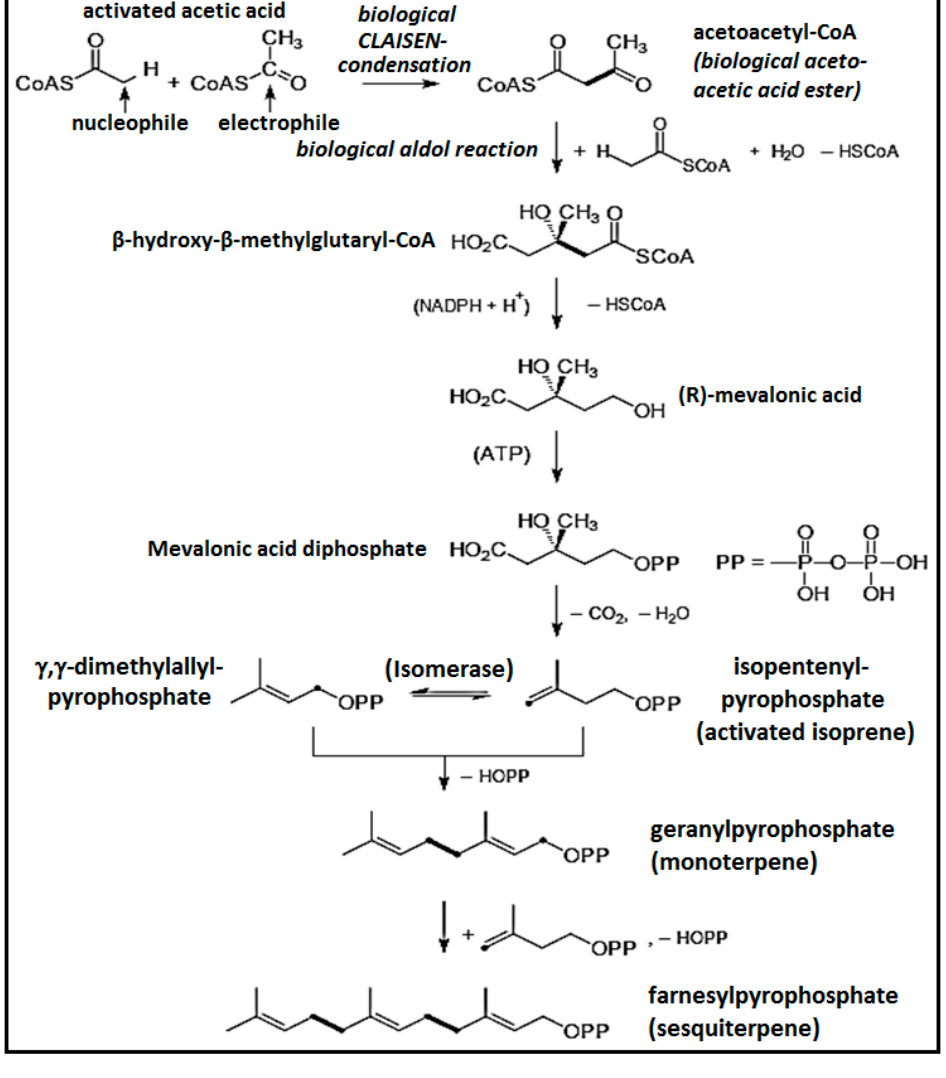
Figure 2. Biosynthesis pathways of monoterpenes and sesquiterpenes.